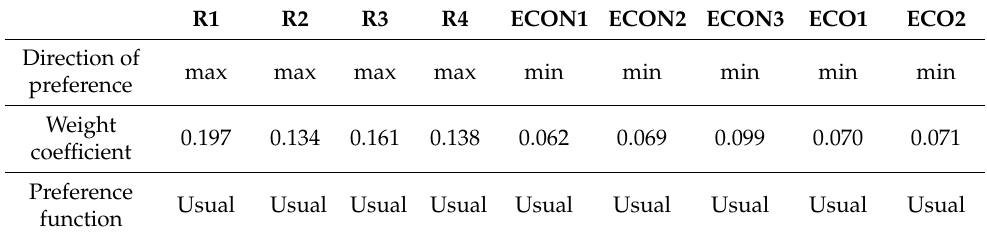
Figure 2. The differences regarding the observed indicators in comparison to the EU average across derived groups of countries in 2014. Table 5. The parameters of multi-criteria analysis for